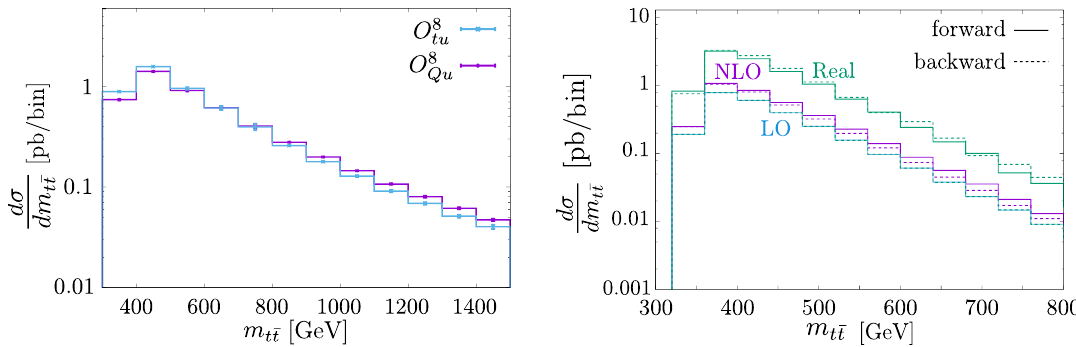
Figure 8 . Left: top pair invariant mass distribution in pp ! t (cid:22) t at NLO for the SM-interference of the RR and LR operators. Right: top pair invariant mass distribution in p (cid:22) p ! t (cid:22) t at NLO in